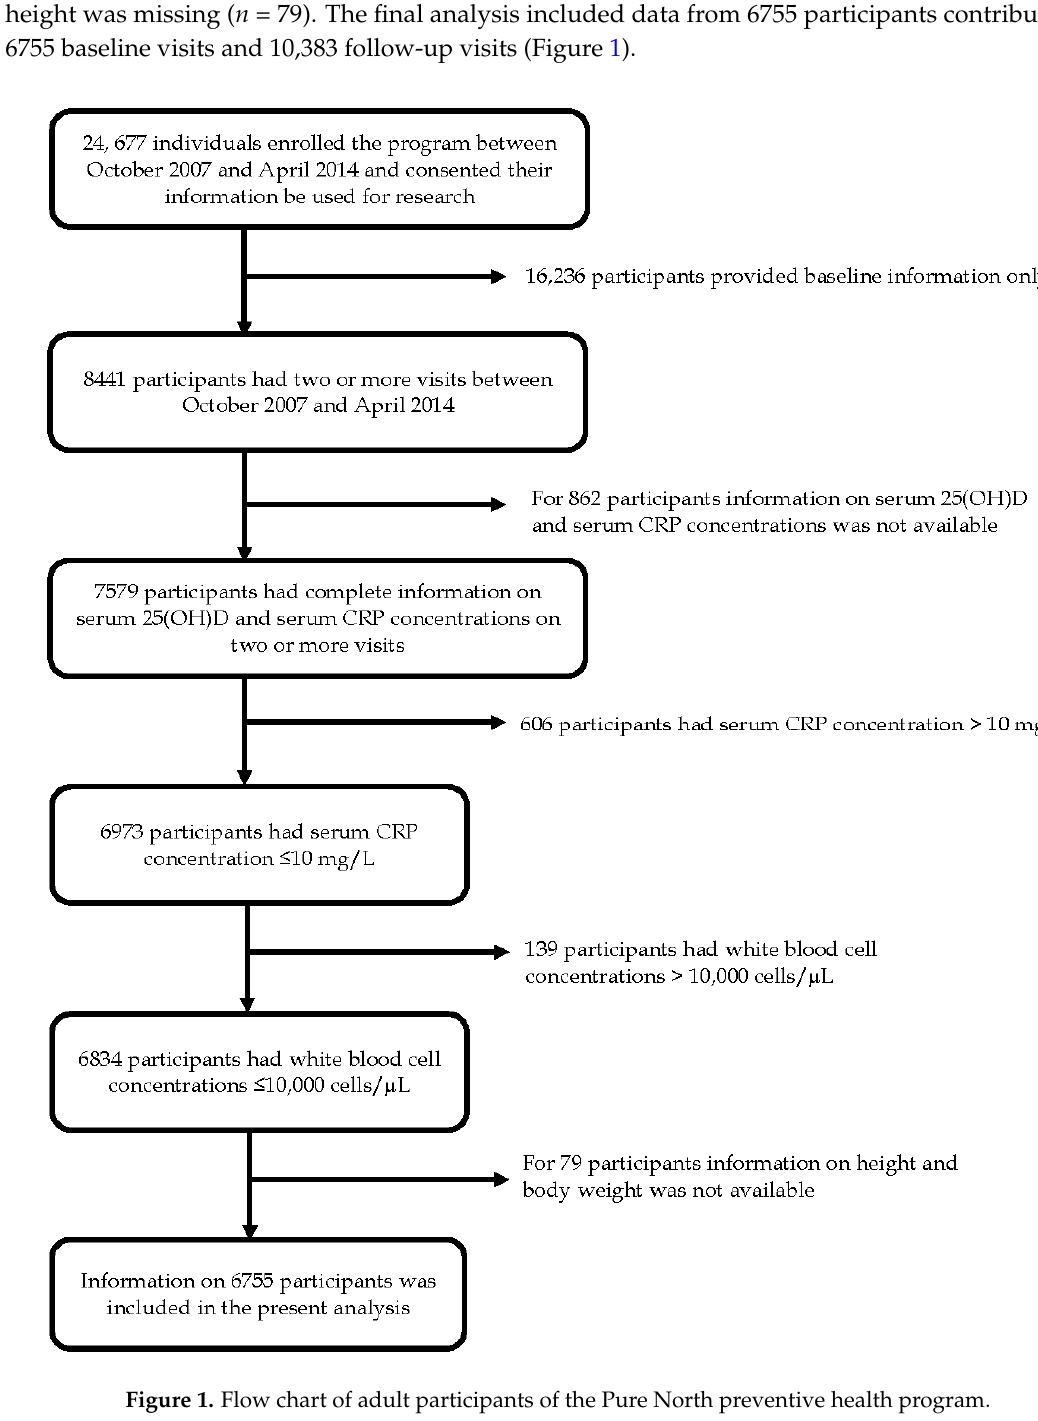
Figure 1. Flow chart of adult participants of the Pure North preventive health program.